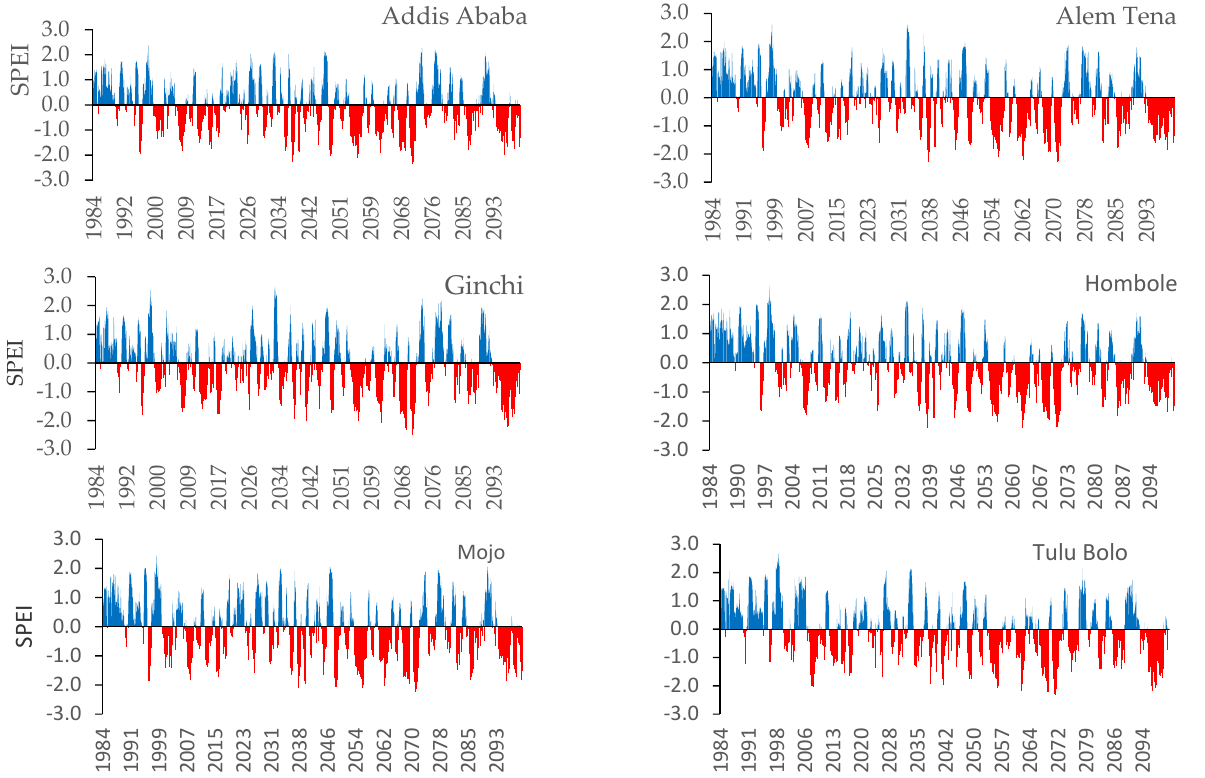
Figure 7. Standard precipitation evaporation index for the baseline and the five GCMs’ ensemble mean (blue indicates wet years and red dry years) .